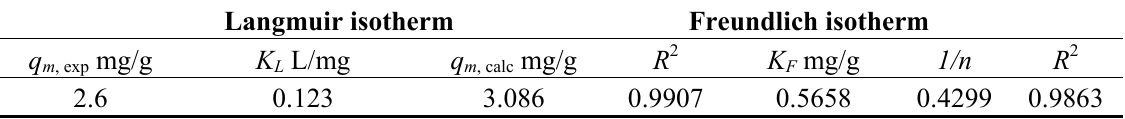
Table 2. Parameters of Langmuir and Freundlich isotherms for Cs + ion adsorption onto Florisil ® impregnated with the studied